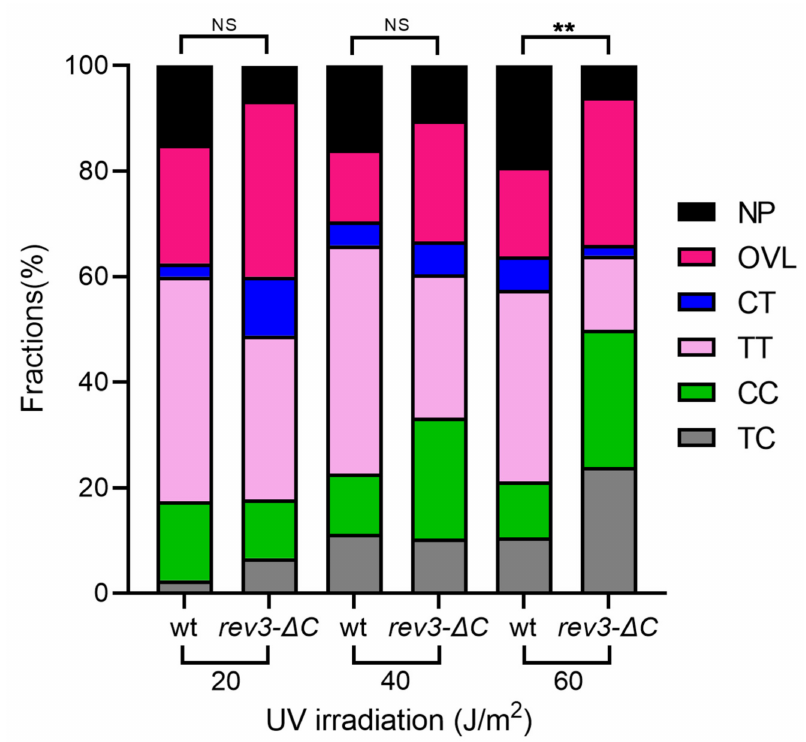
Figure 5. The proportions of mutations at di-pyrimidine sites in the rev3- ∆ C strain differed from the wild-type only at the highest dose. The rev3- ∆ C spectrum at 60 J/m 2 showed a higher proportion of mutations in CC sites and a lower proportion in NP sites compared to the wild-type. NP, non- dipyrimidine sites; OVL, overlapping sites (e.g., TCT with mutated C); CT, 5 (cid:48) CT; TT, 5 (cid:48) TT; CC, 5 (cid:48) CC; TC, 5 (cid:48) TC. ** = p < 0.01, NS =